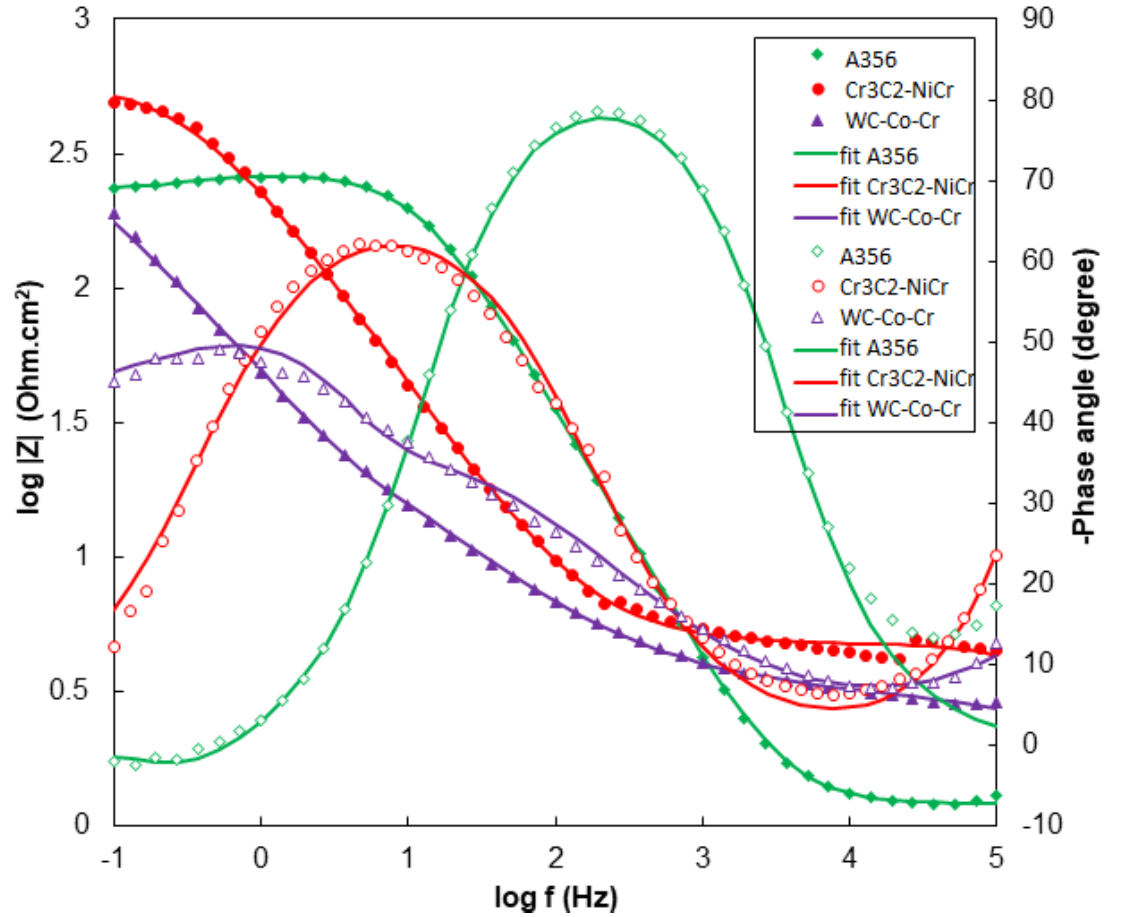
Figure 19. Bode-impedance modulus and Bode-phase angle curves for the samples under test (the points are related to the test result and lines are the fitted results).